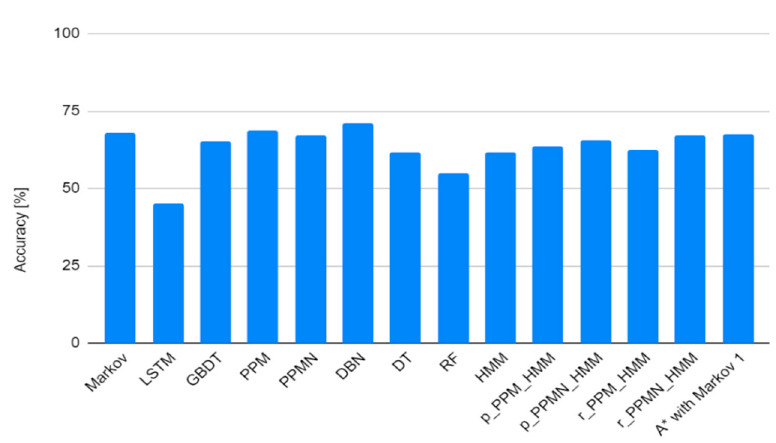
Figure 17. Coverage on the mixed dataset.